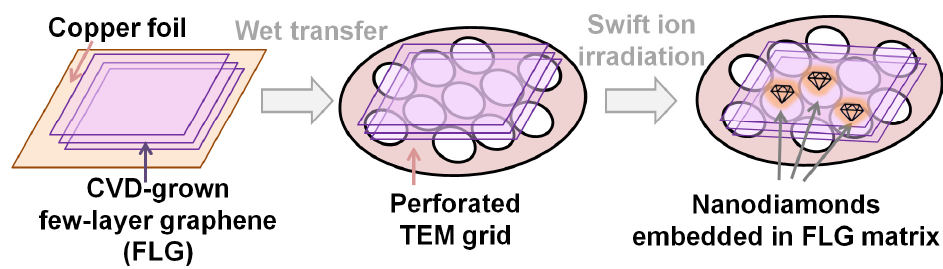
Figure 1. The stages of the sample preparation. Few-layer graphene (FLG) films grown on Cu substrate were transferred onto specialized transmission electron microscopy (TEM) grids. The samples were nanostructured by irradiation with high energy Xe ions.